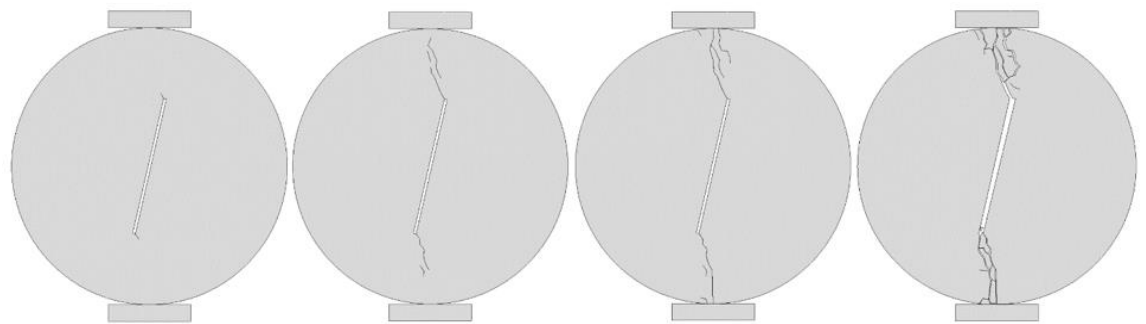
Figure 4. Fracture process for Brazilian disc with a crack of 15° angle.